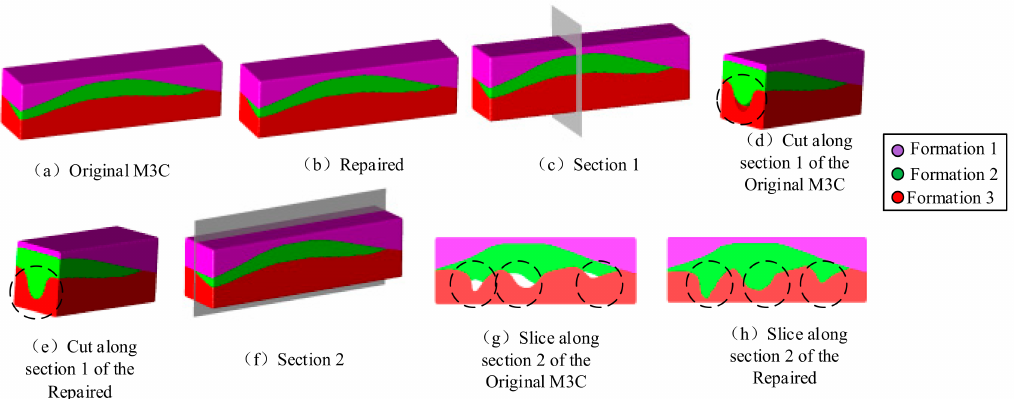
Figure 11. The relationship between the percentages of points modified labels and the voxel size.